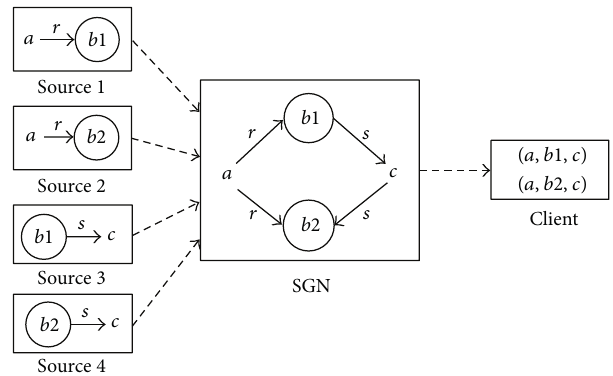
Figure 6: The integration process of the bridging